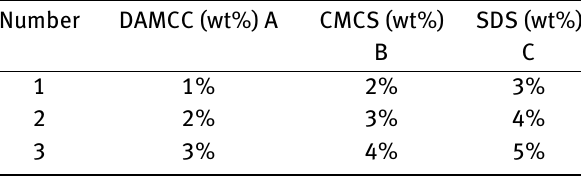
Table 1: Factors and Levels for Orthogonal Experimental Design